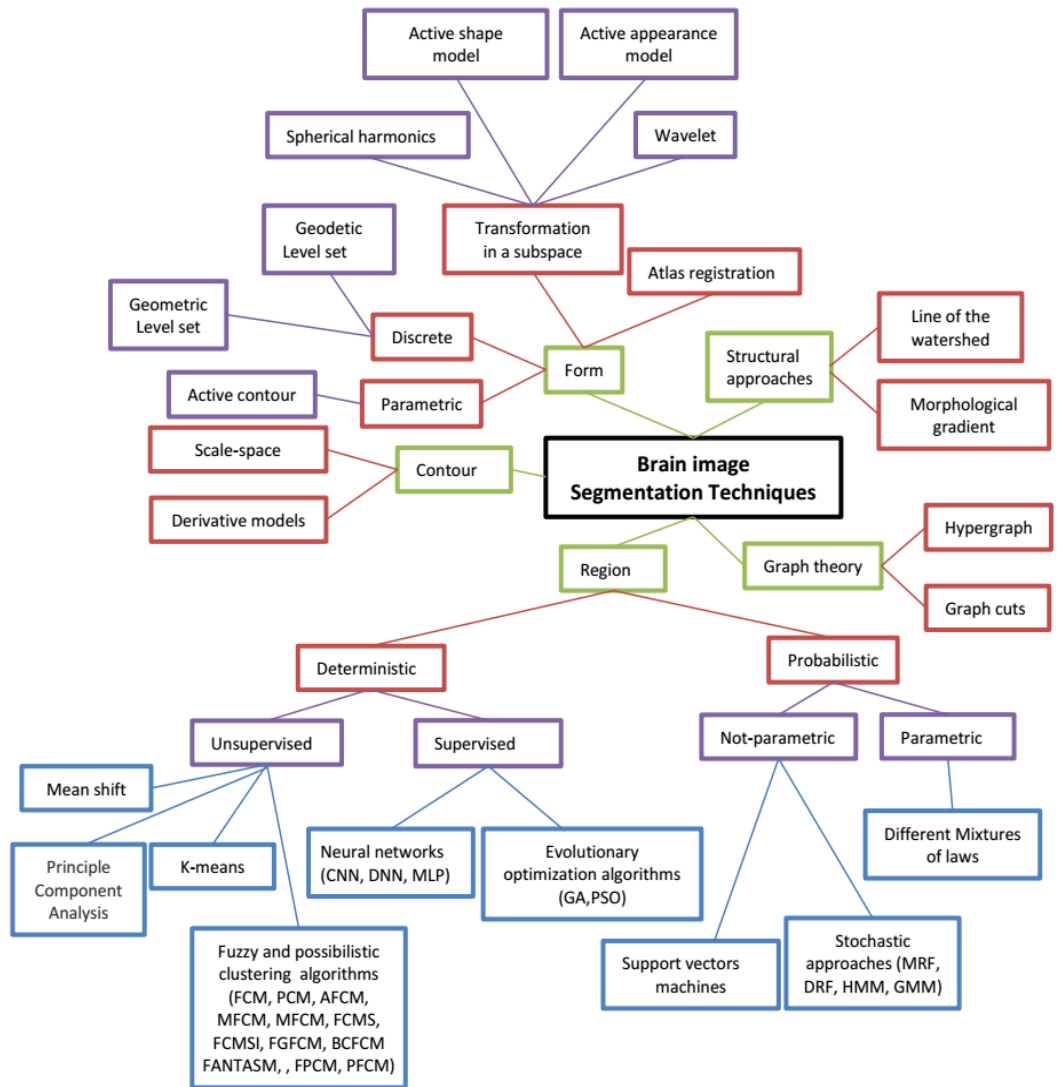
Figure 2. Classification of the various MR brain image segmentation methods described in the literature. In this work, the methods were classified in five categories based on the approaches (in green color): Form, structural approaches, graph theory, region and contour. FCM: Fuzzy C-means, AFCM: Adaptive FCM, MFCM: Modified FCM, FCMS: FCM spatial, FCMSI: FCM with spatial information, FGFCM: Fast generalized FCM, FANTASM: Fuzzy and noise tolerant adaptive segmentation method, PCM: Possibilistic C-means, BCFCM: Bias-corrected FCM, FPCM: Fuzzy PCM, GA: Genetic algorithm, PSO: Particle swarm optimization, MRF: Markov random field, DRFs: Discriminative random fields, HMM: Hidden Markov models, GMM: Gaussian mixture model, DNN: Deep neural network, CNN: Convolutional neural network, MLP: Multi-layer